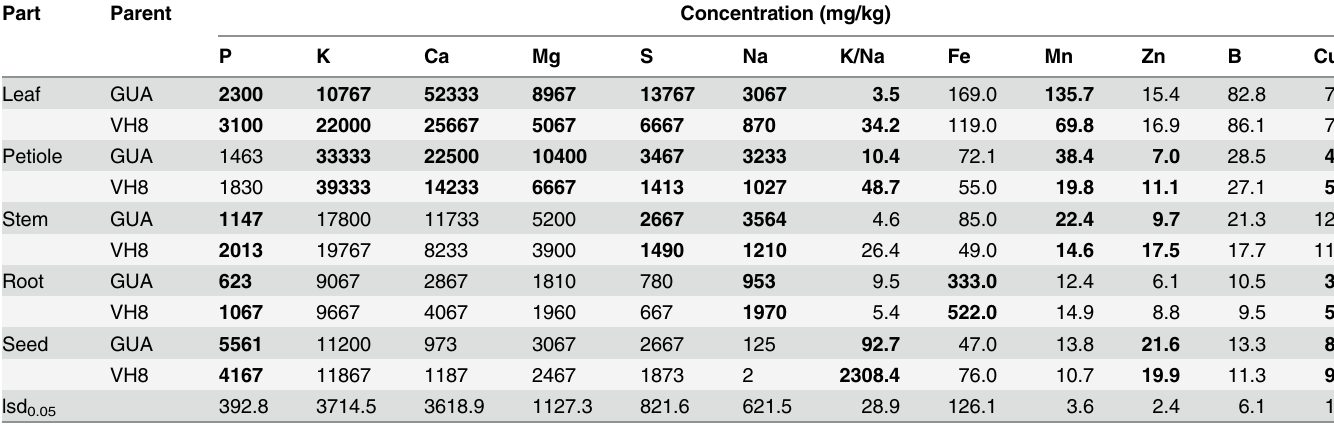
The pairs of bold values within the same plant tissue differed signi fi cantly between parents at P (cid:1)